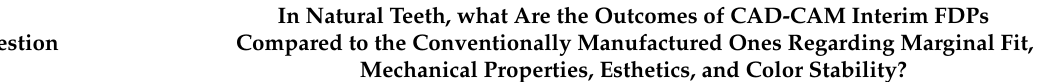
Table 1. Focus question and search